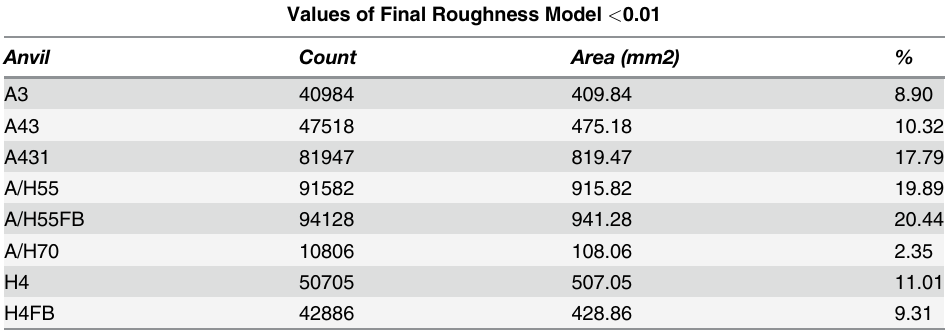
Table 1. Percentage of lowest roughness areas in stone tool surfaces.